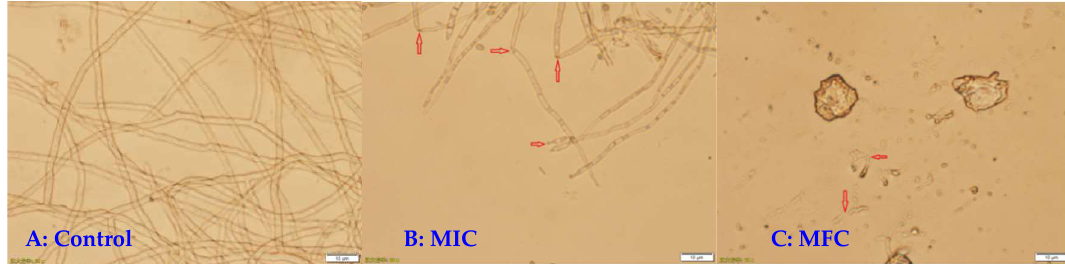
Figure 2. Effect of DEM on hyphal morphology of P. italicum . normal mycelial morphology ( A ), mycelia treated with MIC of DEM ( B ), mycelia treated with MFC of DEM ( C ).